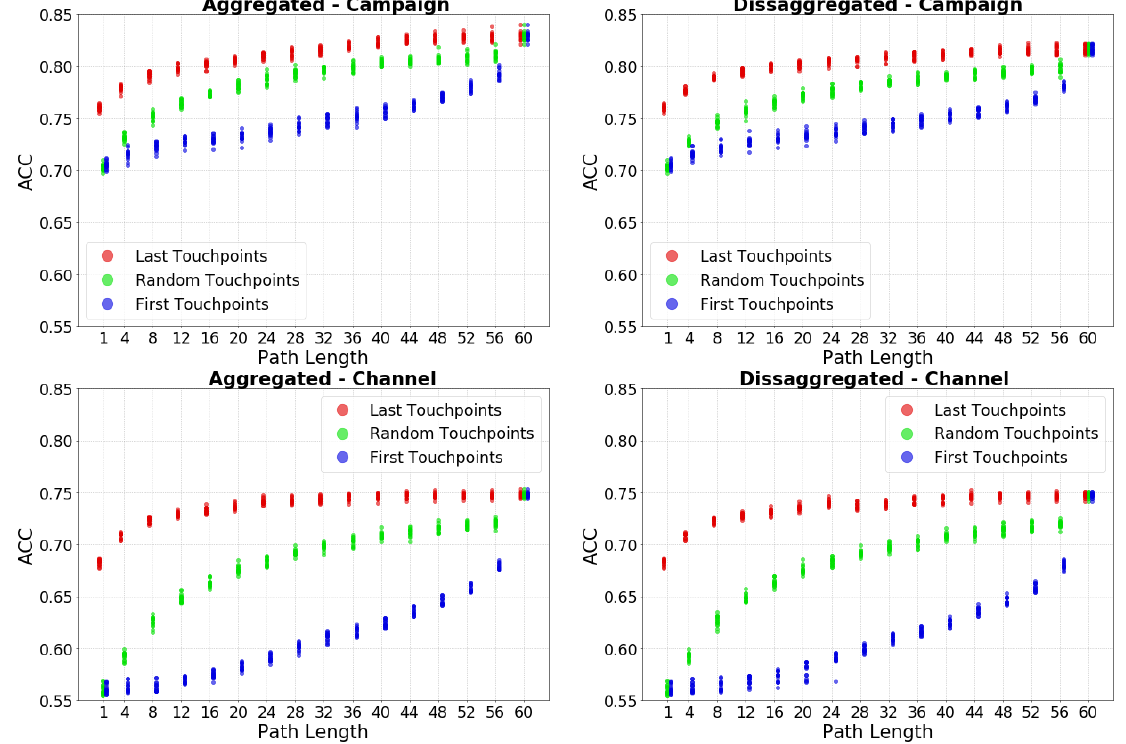
Figure 5. Comparison of the accuracy in the linear model for each of the recencies of information. Preferably see it in